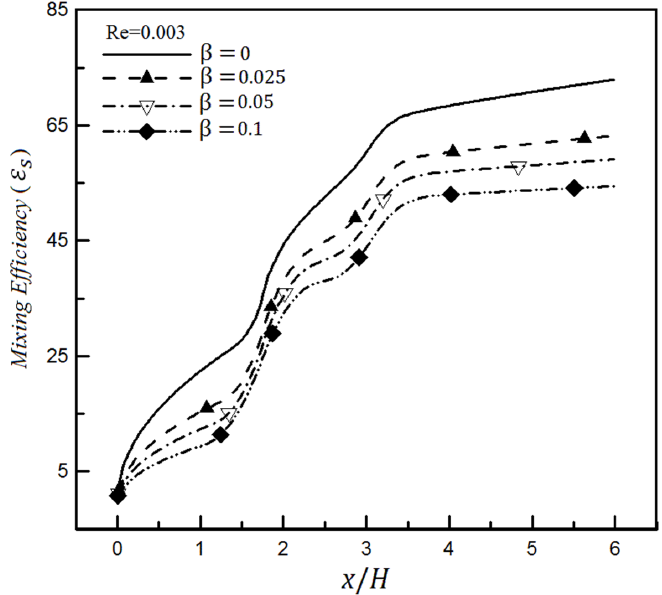
Figure 11. Mixing efficiency variations for different slip coefficients inside a microchannel having a heterogeneity patch based on mixing entropy index and Re = 0.003. a heterogeneity patch based on mixing entropy index and Re = 0.003.